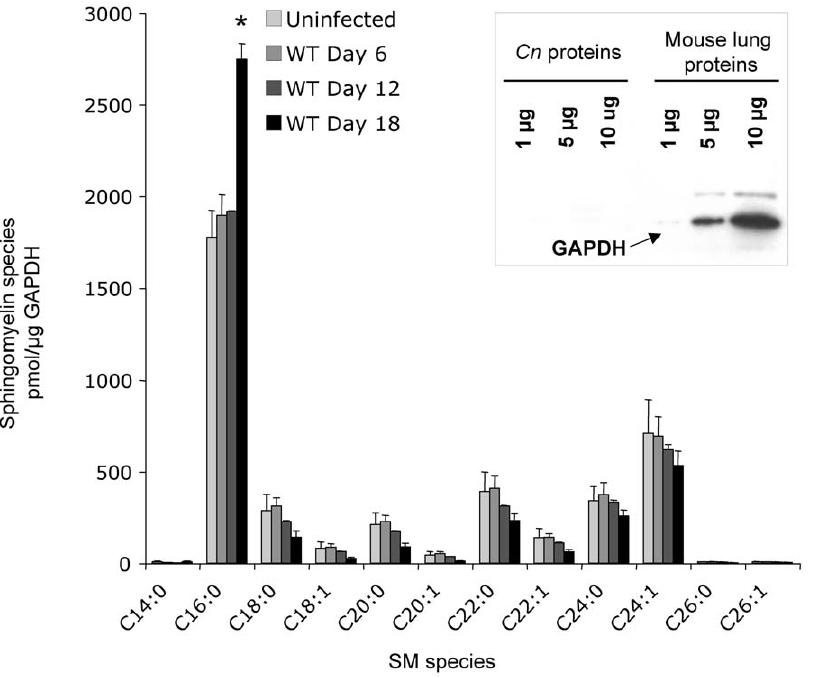
Figure 10. Liquid Chromatography Mass spectrometry (LC/MS) analysis of mouse lungs infected with wild-type Cneoformans ( Cn ). Quantitative measurements by mass spectrometry (HPLC-MS/MS) of different sphingomyelin (SM) species in uninfected and Wild-type (WT)-infected lungs excised from CBA/J mice. Data were normalized to the level of mouse GAPDH protein in lungs using mammalian anti -glyceraldehyde 3- phosphate dehydrogenase (GAPDH) antibody from Ambion (Cat # AM4300), which shows specificity against the mammalian and not against the Cn GAPDH protein (inset). *, P , 0.05, Day 18 versus Day 12.